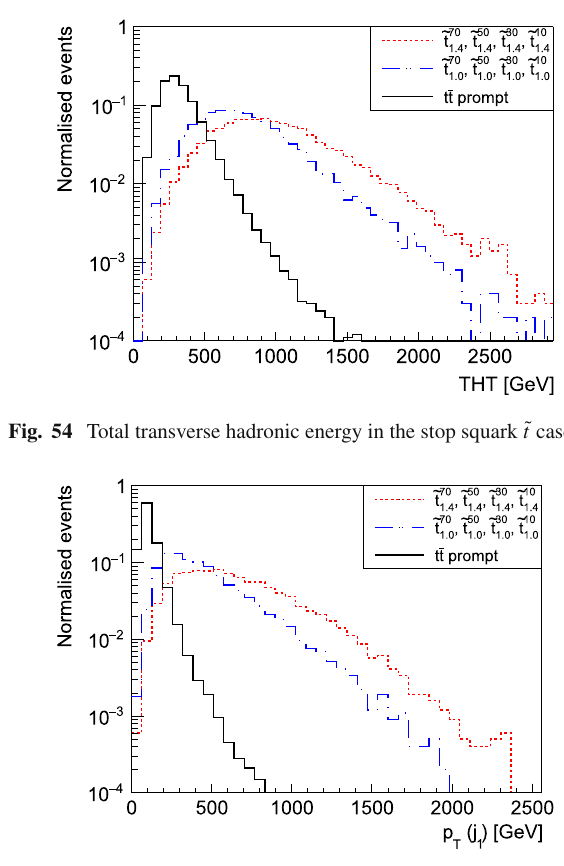
Fig. 55 Transverse momentum p T of the leading jet in the stop squark ˜ t case the top quark) get closer, they appear as one fat jet instead of several jets. To investigate this effect, the distributions (cid:3) (cid:6)η( bq ) 2 + (cid:6)φ( bq ) 2 have been displayed of (cid:6) R ( bq ) = (see Fig. 48). This variable characterises the angular distance between b quarks and the closest light quark coming from the W boson decay, which also arises from t → bW . Through the anti- k T algorithm with (cid:6) R = 0 . 4 and p min .